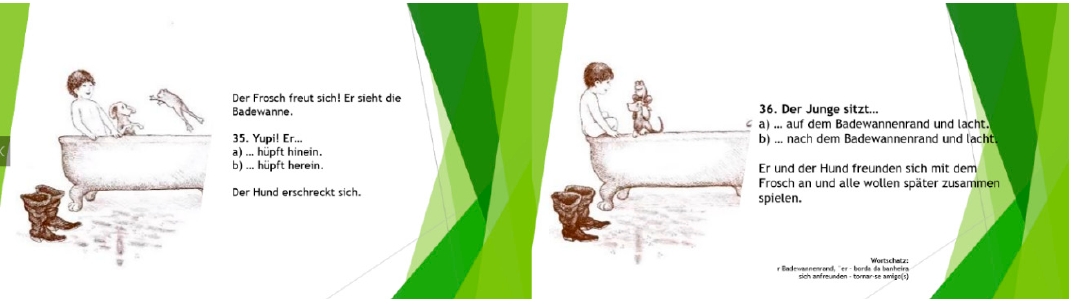
Figure A26. Pretest: Binary-choice recognition task.